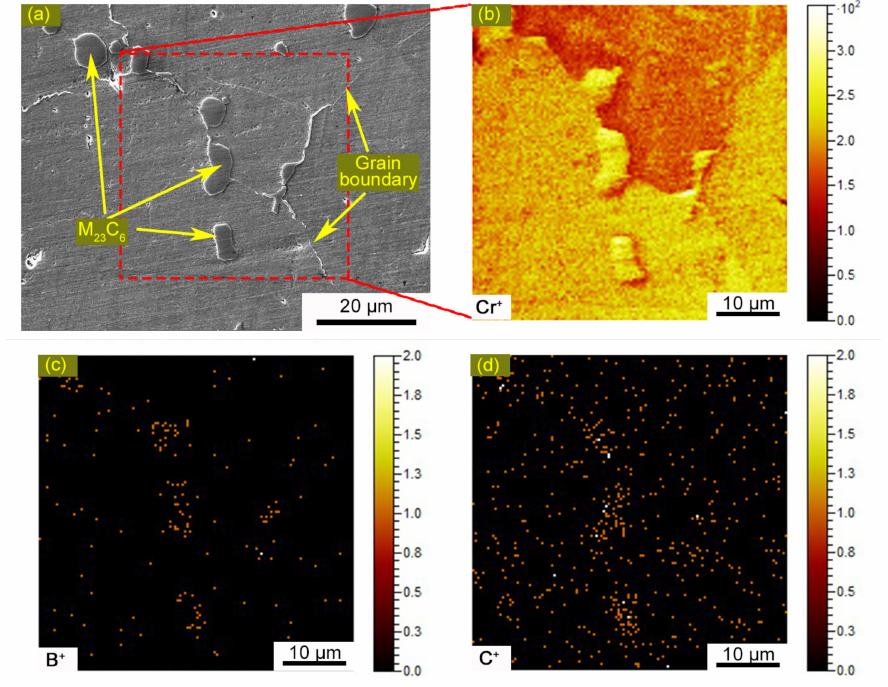
Figure 10. ( a ) SEM micrograph of BM and SIMS micrographs of ( b ) Cr + , ( c ) B + and ( d ) C + distribution in ( a